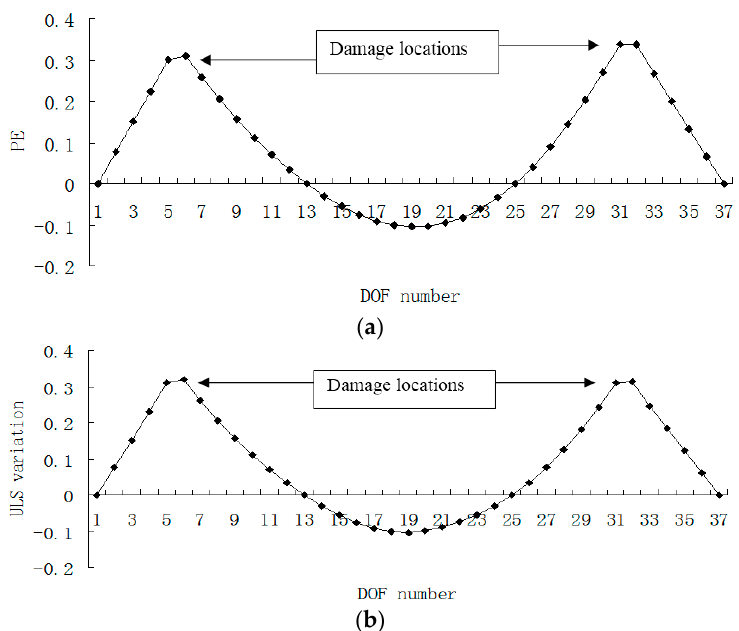
Figure 11. ( a ) Damage index (PE) map using the first four exact modes when the defects occurred in elements 5 and 31; ( b ) Damage index (ULS variation) map using the first four exact modes when the defects occurred in elements 5 and 31 (×10 − 4 ).